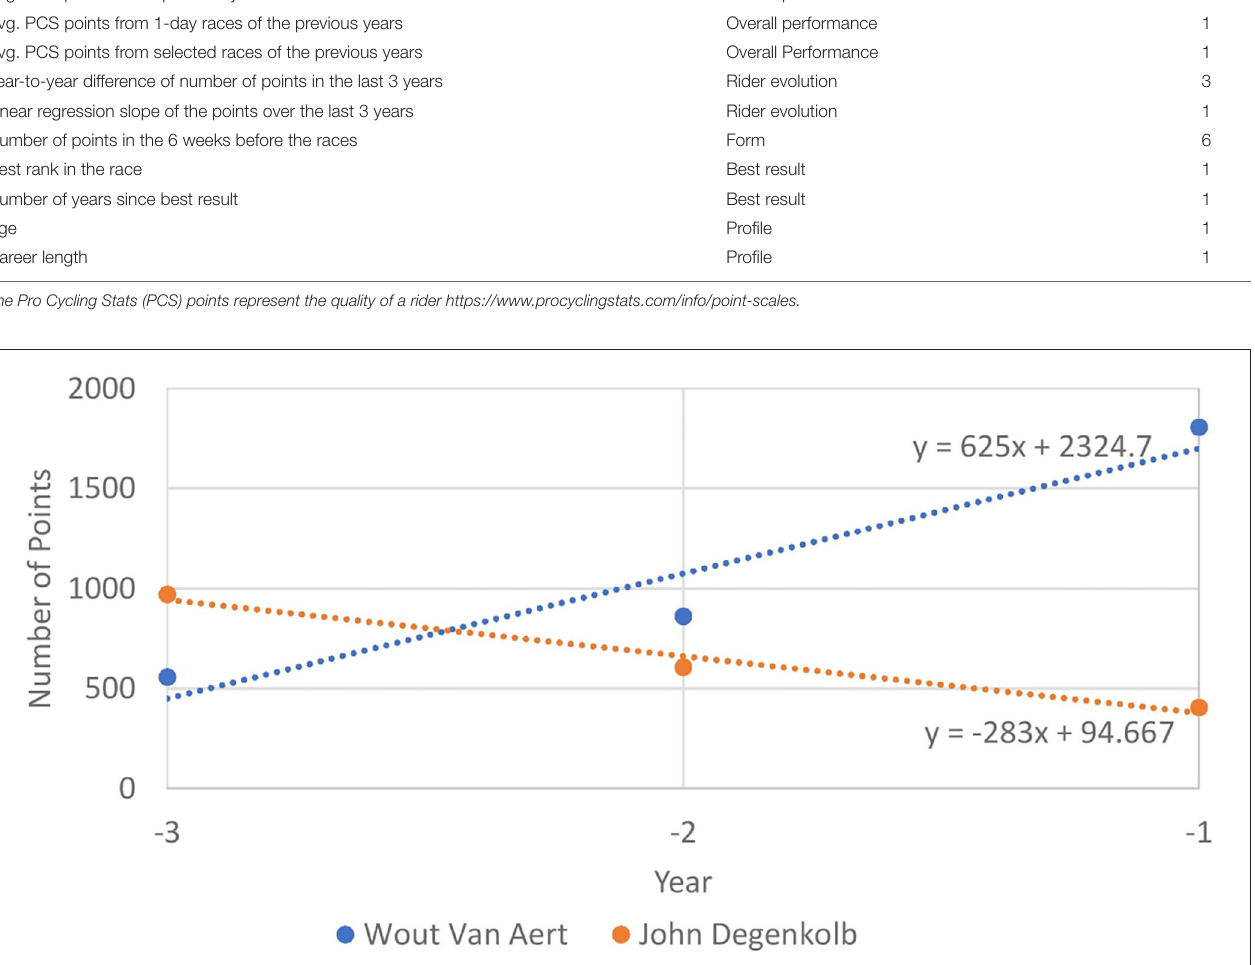
FIGURE 3 | Evolution of the number of Pro Cycling Stats points that Wout van Aert and John Degenkolb won in the 3 years before 2021 (from 2018 to